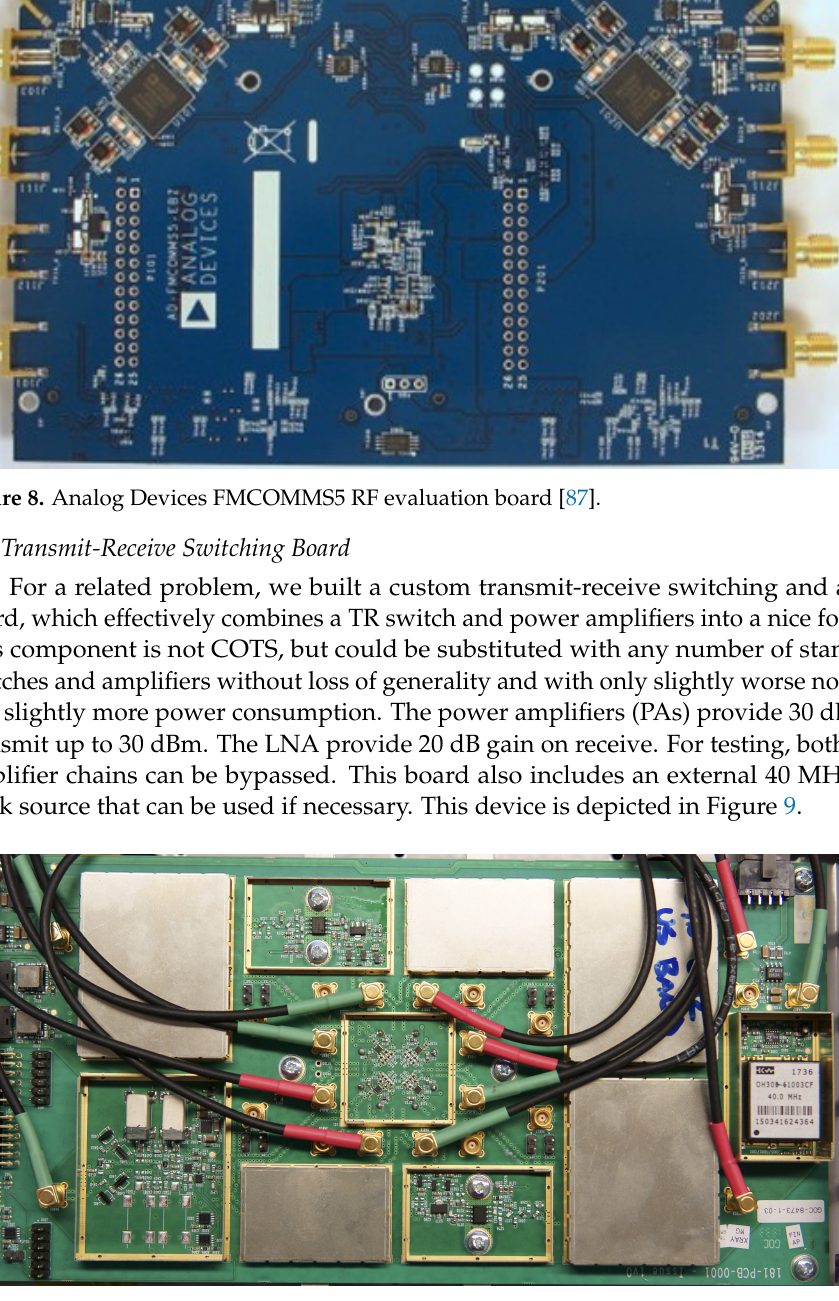
Figure 9. Customized transmit-receive switching and amplifier